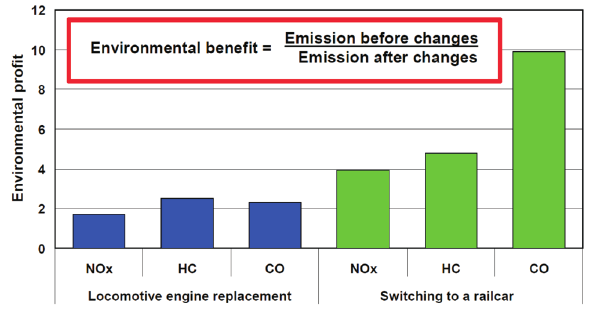
Fig. 19. Ecological benefit: the multiplicity of the ecological benefit of the most efficient solutions